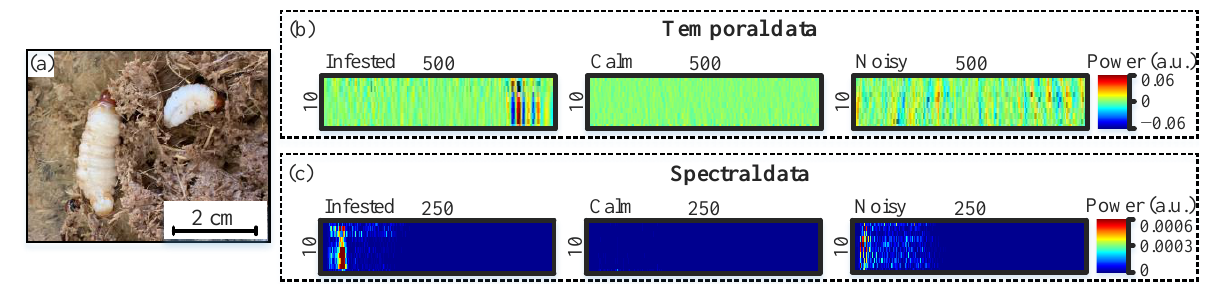
Figure 3. ( a ) Weevil larvae less than three weeks old. Representative examples of the temporal “infested”, “calm”, and ”noisy” images ( b ), and their corresponding spectral images ( c ). Figure 4a shows the architecture of the CNN model used to handle the temporal (spectral) input data. The CNN architecture includes an input layer, two pairs of convo- lutional and max pooling layers, a flattened layer, a fully-connected layer, and an output layer, respectively. The first convolutional layer has the ReLu activation function and comprises 16 (32) filters of a 3 × 50 (3 × 5) size and a 1 × 1 (1 × 1) stride, while the first max pooling layer has a 2 × 2 (2 × 2) pool size. In contrast, the second convolutional layer also has the ReLu activation function and includes 32 (32) filters of a 3 × 3 (3 × 3) size and a 1 × 1 (1 × 1) stride, while the second max pooling layer includes a 2 × 2 (2 × 2) pool size. Following the flattened layer, the fully-connected layer has the ReLU activation function and includes 50 (50) nodes. Eventually, the output layer of the CNN contains a single node with a sigmoid activation function for binary classification (“infested” or “healthy” signal).